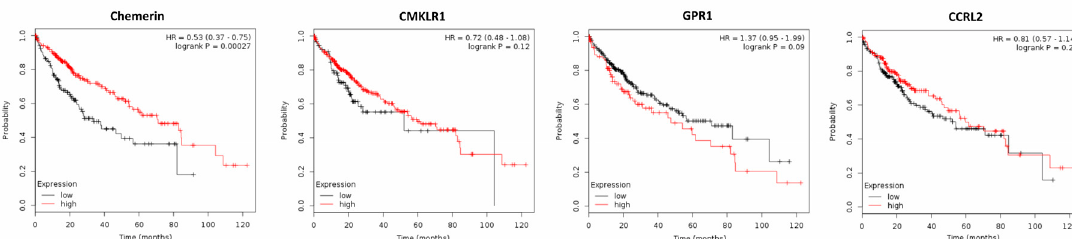
Figure 6. Kaplan–Meier diagrams showing the overall survival (OS) of 364 patients with hepatocellular carcinoma (HCC) depending on expression of chemerin and its receptors CMKLR1, GPR1 and CCRL2 in tumor tissue, based on a metaanalysis of DNA microarray data (http://kmplot.com/analysis/)